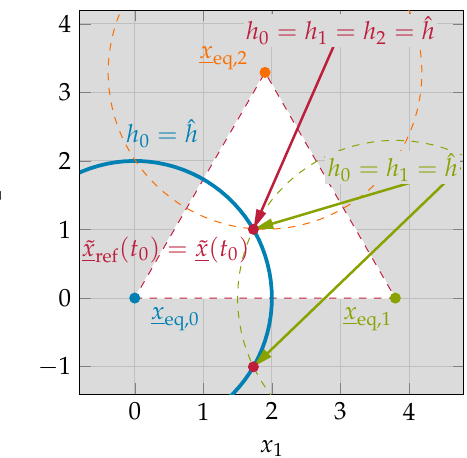
Figure 6. Intersection of h s ( ˜ x ( t ) , ˜ x ref ( t )) = ˆ h for all s ∈ S = { 0,1,2 }